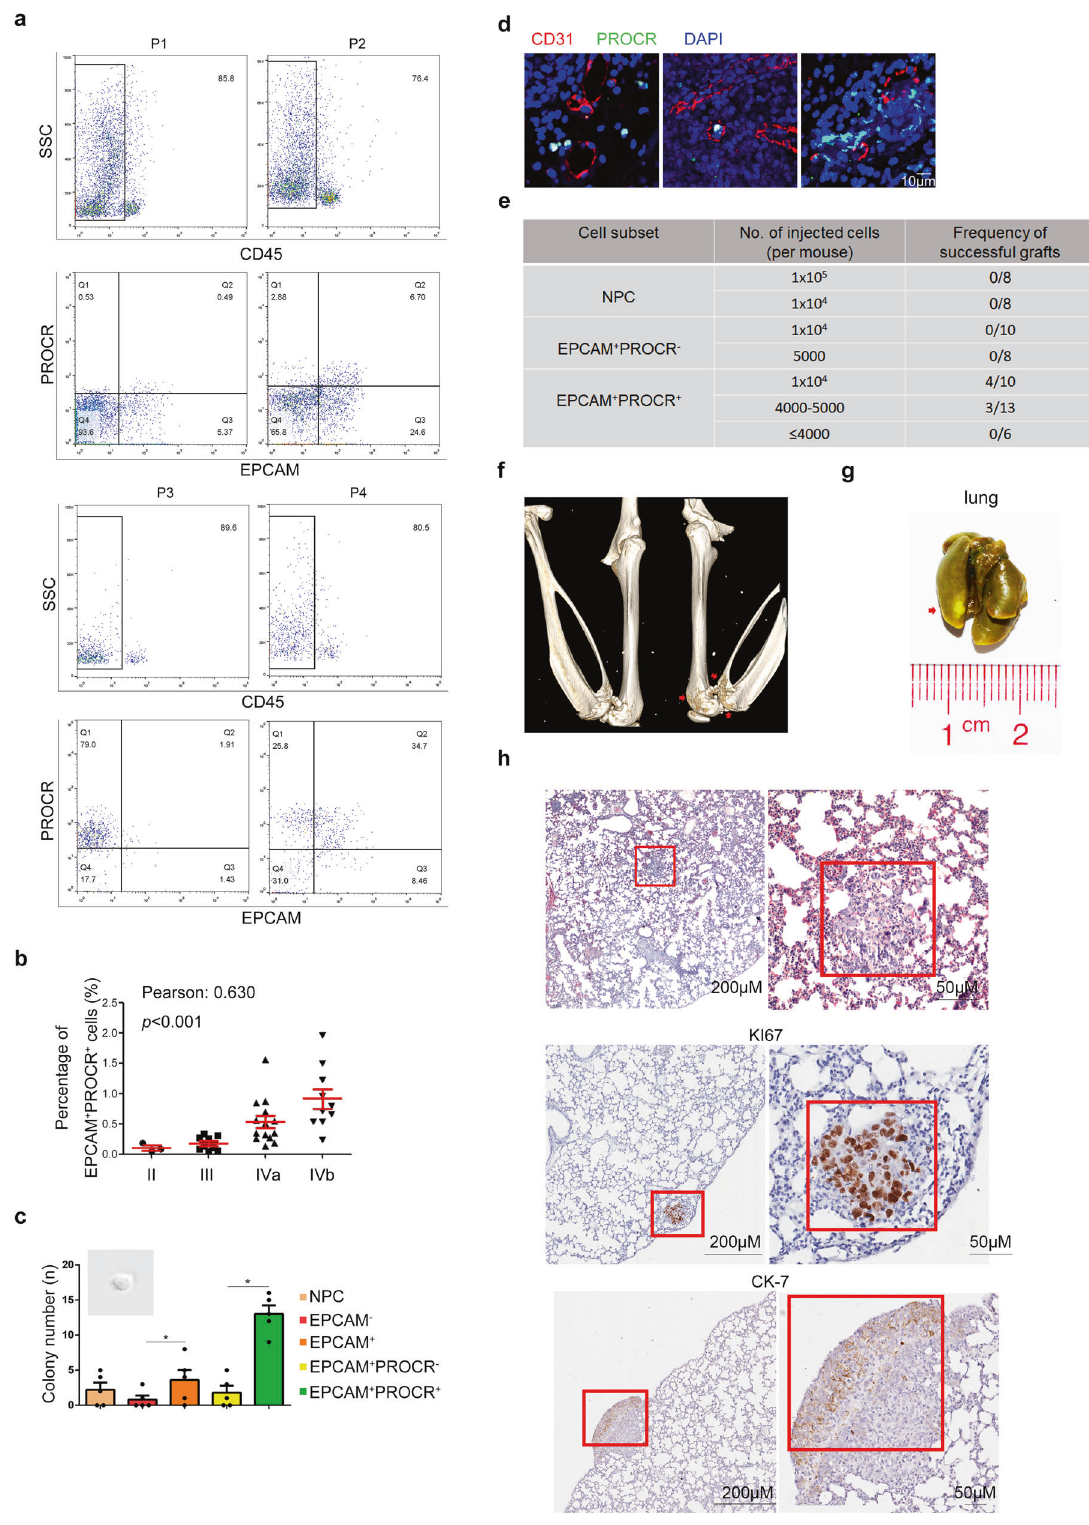
(TNM) stages, and found that the epithelial cell adhesion molecule (EPCAM) + PROCR + cell population could be distinguished from other cell subtypes by their overrepresentation in specimens with advanced disease stage (Fig. 1a). Further analysis in a cohort of 51 patients showed that the percentage of CD45 − EPCAM + PROCR +